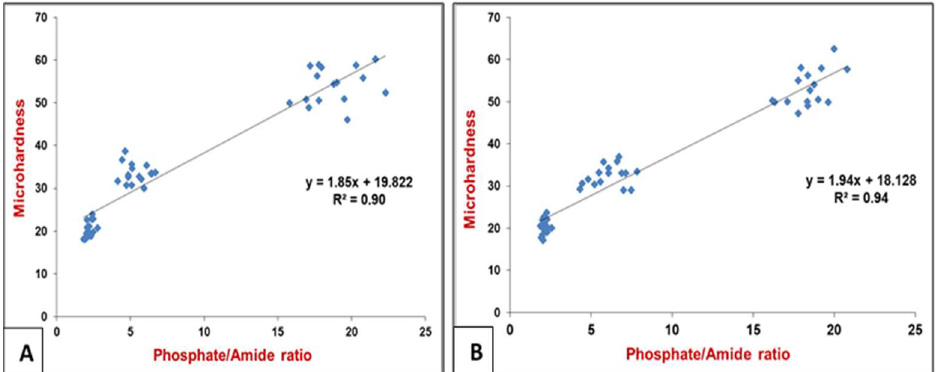
Figure 5. A scatter plot and a regression line (R) demonstrating the presence of a logarithmic regres- sion relationship ( p < 0.000) between the Raman peak ratios (phosphate v1: amide I) and Vickers microhardness (VHN) in the sound and demineralized dentin (CID and CAD) in the occlusal lesion ( A ) and proximal lesion ( B ). The peak ratio is lower in CID with reduced mineral contents which gradually increased towards sound dentin (more phosphate v1).